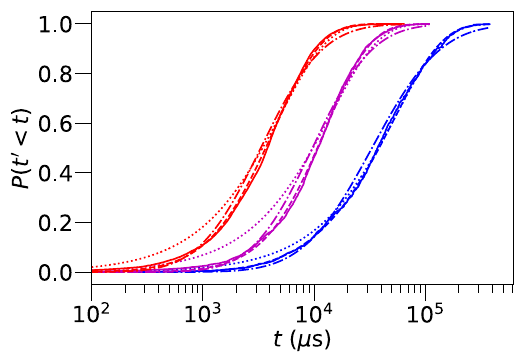
FIG. 5. CDF of the time interval between current spikes for electric fields of 31.3, 35.4, and 39 . 6 MV = m (from right to left), from series D. For each field, the CDF calculated from experi- ment is drawn as a solid line. The other lines represent best fits to hypoexponential (dashed), exponential (dotted), and log-normal (dash-dotted) distributions.